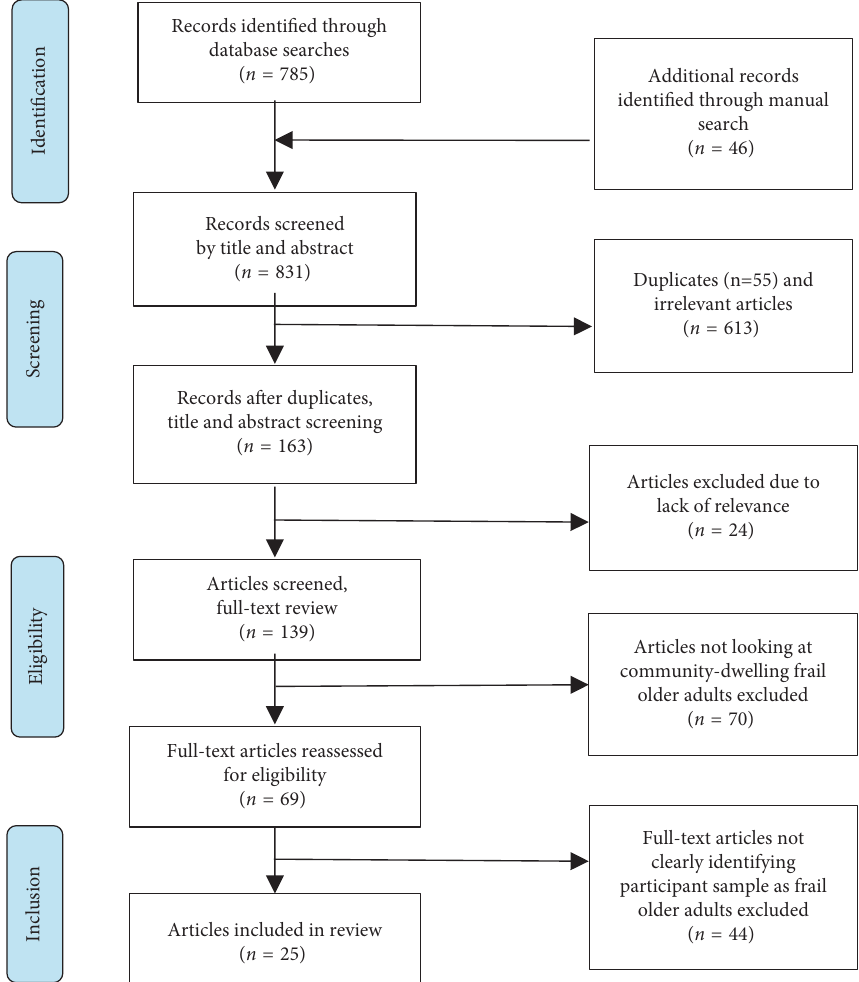
Figure 1: Search strategy flow